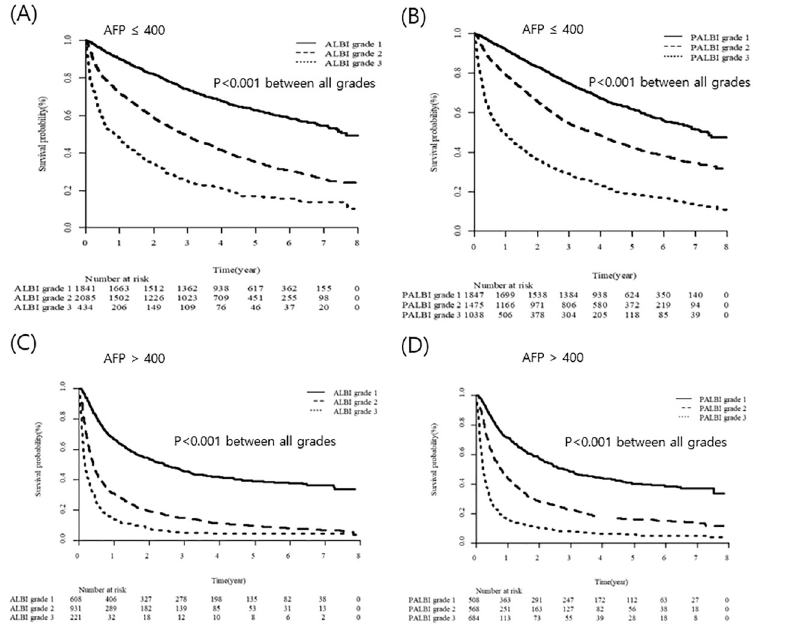
Fig 5. Utility of ALBI and PALBI grades according to tumor marker.